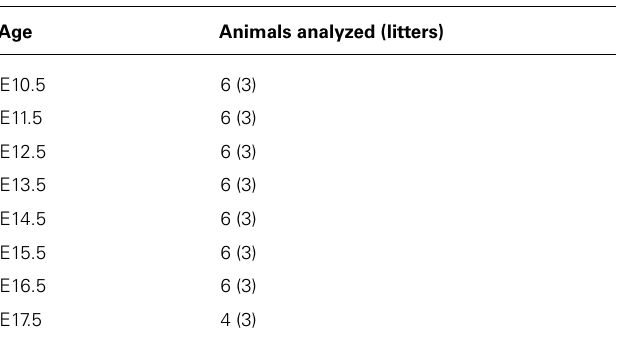
Table 1 |Time and animal numbers designed for BrdU